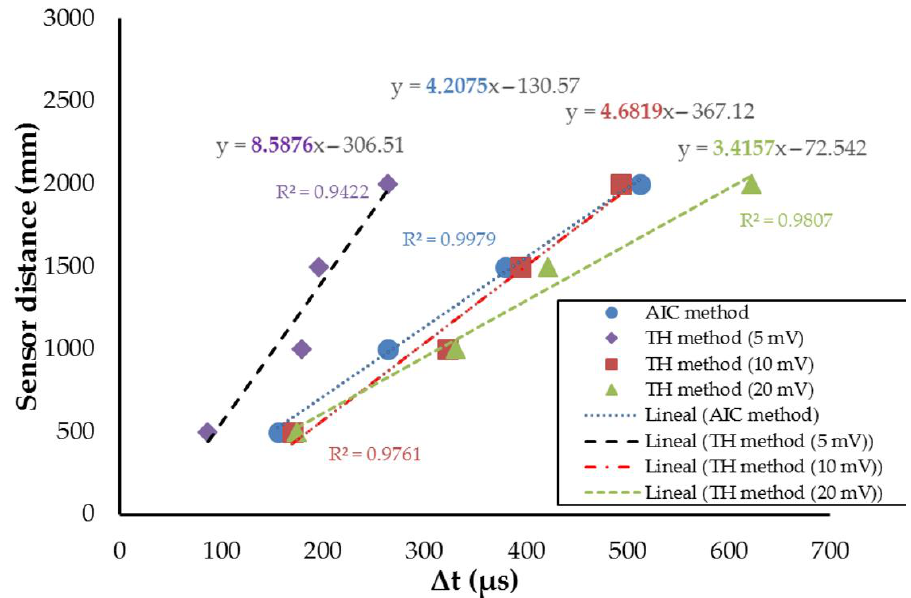
Figure 20. Wave propagation velocity obtained using the AIC and the TH techniques with different thresholds: 5, 10 and 20 mV.